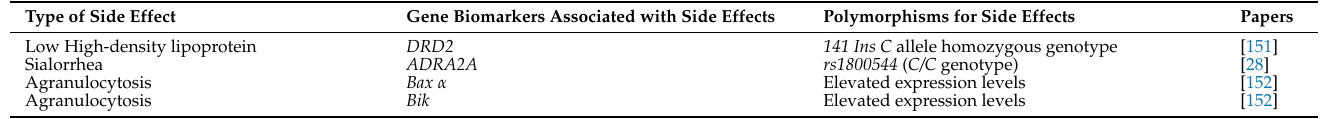
Table 3. Genes/polymorphisms associated with Clozapine side